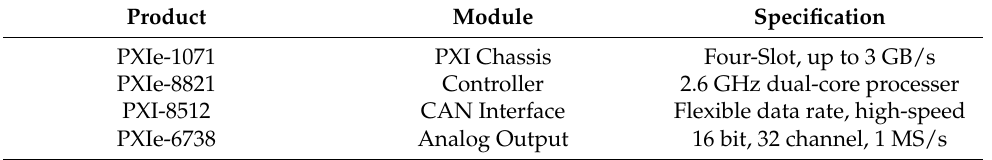
Table 2. Parameters of the NI PXI